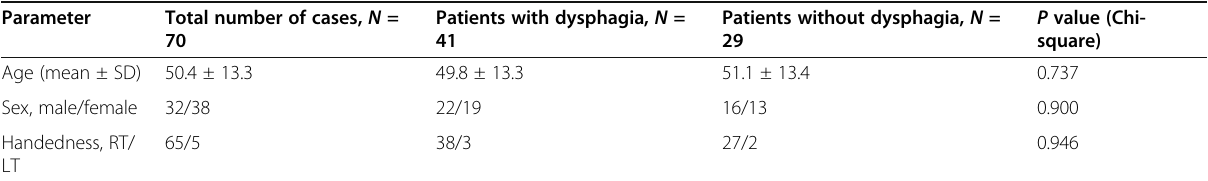
Table 4 Demographic data of all hemorrhagic stroke patients Parameter Total number of cases, N = 70